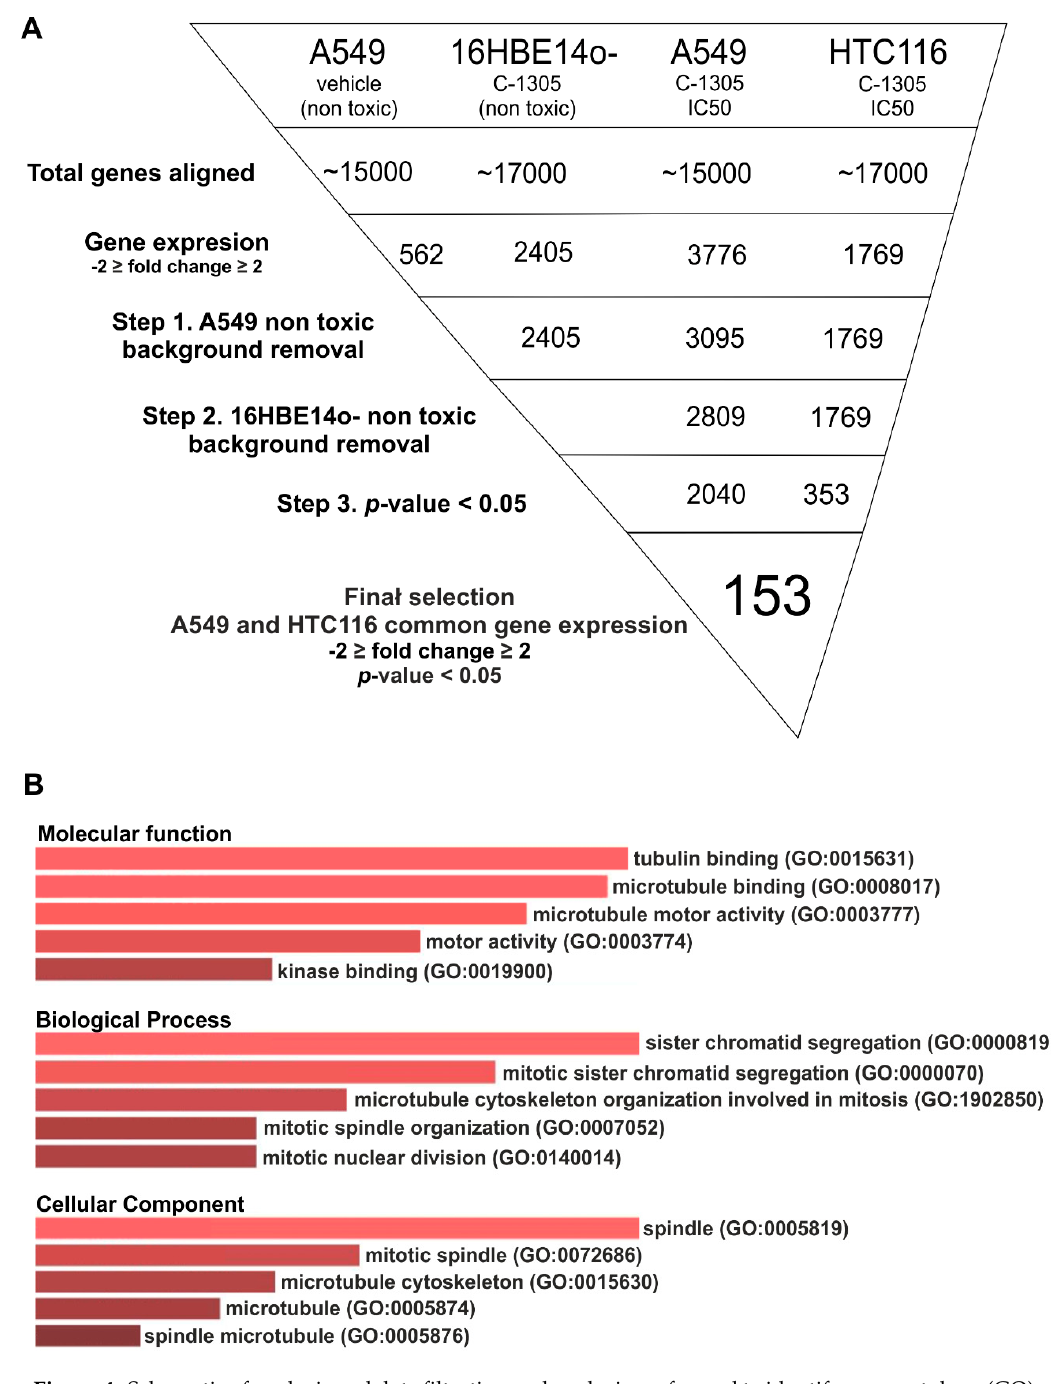
Figure 4. Schematic of analysis and data filtration and analysis performed to identify gene ontology (GO) terms of significantly dysregulated genes. ( A ) Schematic of analysis and data filtration Following the flirtation of gene transcript potentially related to A549 growth and no cytotoxic e ff ects in 16HBE14o-cells. The common gene transcripts dysregulated in both A549 and HTC 116 were selected. Well-established gene transcripts (no predicted gene transcripts, gene names starting with “LOC”) with greater than 10 RPKMs per sample and with significance ( p ≤ 0.05) greater or equal to a 2-fold change in expression between C-1305-treated and control groups were used in pathway analyses. ( B ) The GO clusters are depicted for selected genes; clusters are listed followed by the enrichment score calculated by Enricher, which is used to determine the percentage of the pie chart. The darker the color, the more enriched the cluster.